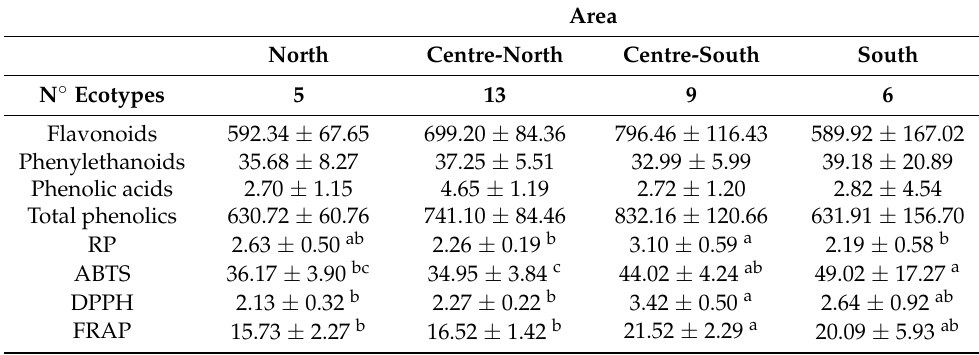
Values in the same row with different letters are significantly different ( p ≤ 0.05) following Fisher’s LSD